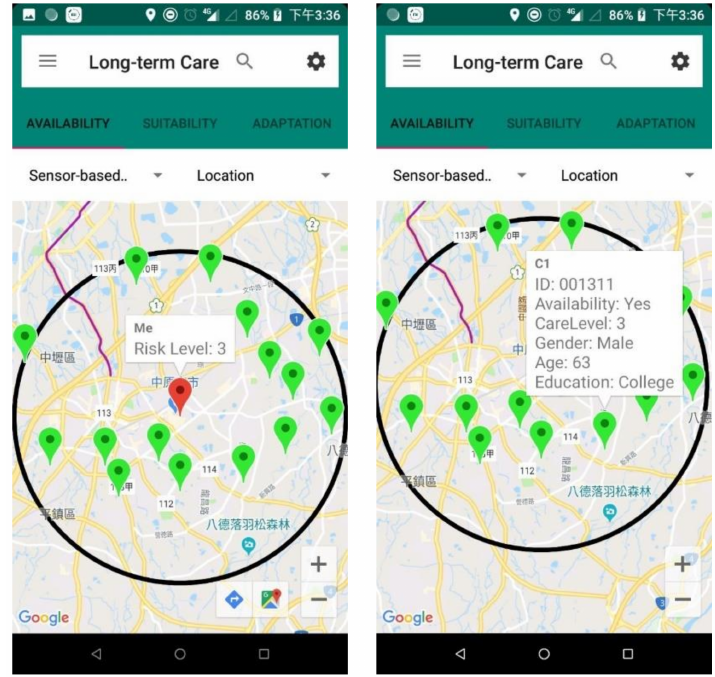
Figure 4. The Prototype System of Long-term